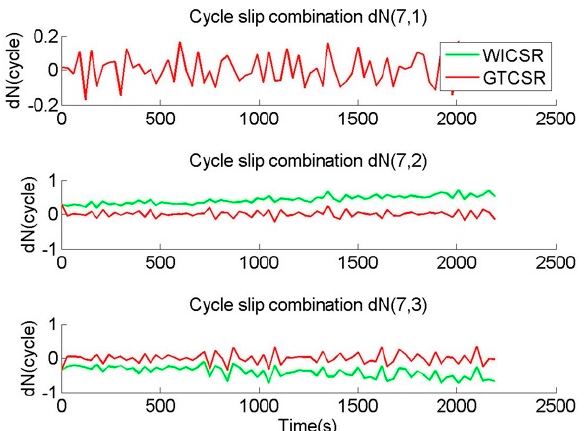
Figure 3. The GTCSR cycle slip combinations after correcting the ionospheric variation and WICSR cycle slip combinations without correcting the ionospheric variation, where the pseudoranges and phases without cycle slips were collected at CUT0 station on GPS satellite 25 during the geomagnetic storm that started from UTC 2016/05/08 00:00:00; GTCSR is the GPS triple-frequency cycle slip repair (CSR) method; WICSR is the CSR without correcting the ionospheric variation.